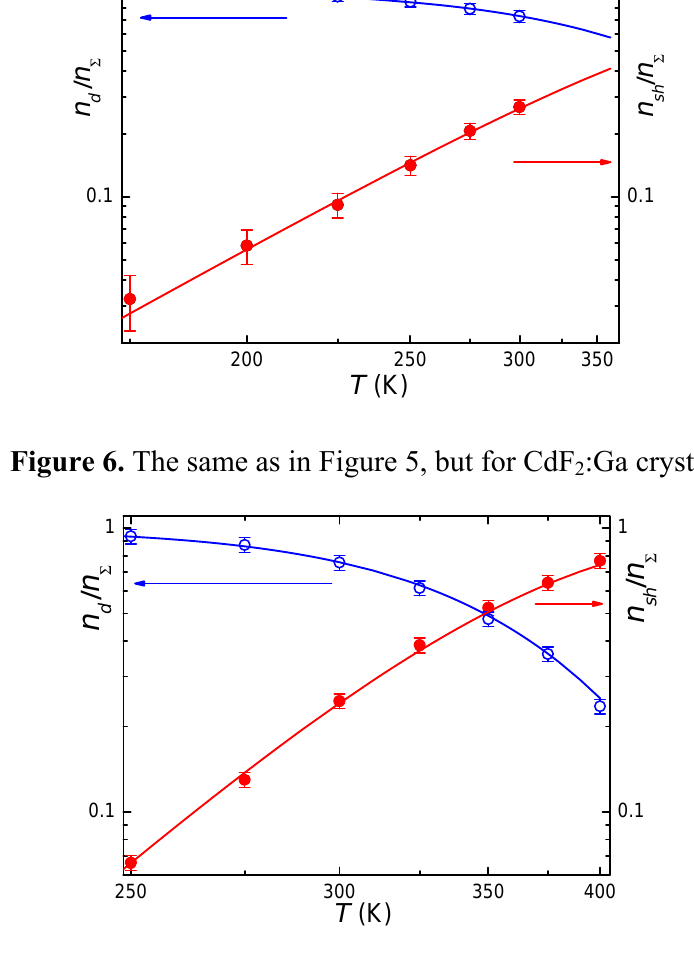
Figure 5. Temperature dependencies of relative concentrations of carriers at deep, d n  and shallow, sh , centers for CdF n  Σ (shallow centers) are experimental data; solid lines show theoretical dependency as calculated in [28].